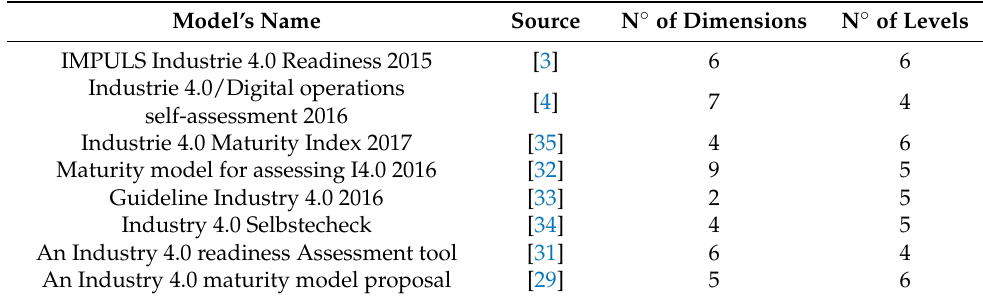
Table 1. I4.0 maturity/readiness models.